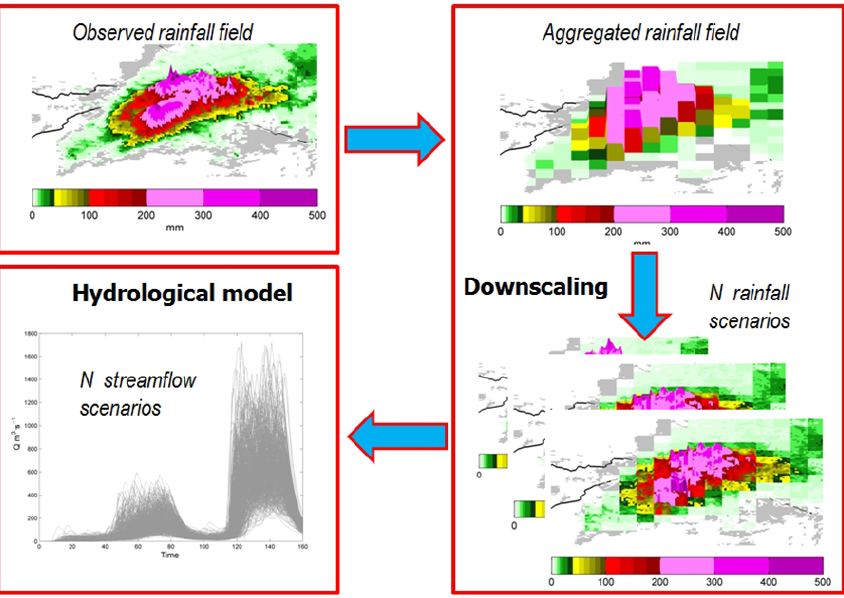
Figure 4. Schematization of the flood forecast framework made by a downscaling model and a hydrological model. In this application the rainfall field is the one reported in Fig.